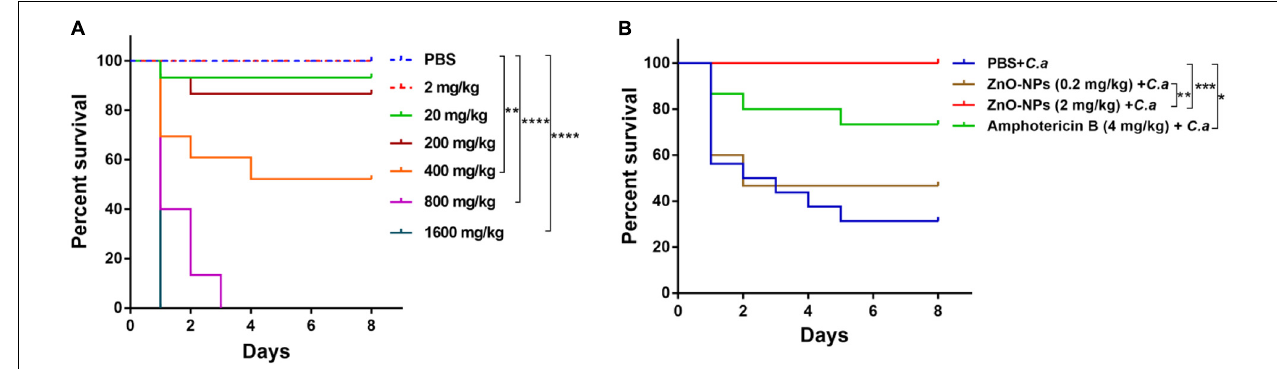
FIGURE 2 | The toxicity of ZnO-NPs on Galleria mellonella and the efficacy of ZnO-NPs saving G. mellonella from Candida albicans infection. (A) Survival curves of G. mellonella larvae injected with various concentrations of ZnO-NPs. Larvae were injected with ZnO-NP suspensions at concentrations ranging from 2 to 1,600 mg/kg. Phosphate-buffered saline (PBS) was injected as the control. (B) Survival curves of G. mellonella receiving ZnO-NP pretreatment and C. albicans challenge. Larvae were pretreated with ZnO-NPs at non-toxic concentrations (0.2 and 2 mg/kg). Pretreatment with amphotericin B (4 mg/kg, 5 µ l) and sterilized PBS was used as the positive and negative controls, respectively. Larvae were immunized with 1 × 10 5 colony-forming units (CFU) of C. albicans 2 h postinoculation. Fifteen larvae were used per group in one experiment. The experiments were repeated in triplicate independently. Differences were determined by using the log-rank test. * p < 0.05; ** p < 0.01; *** p < 0.001; **** p <